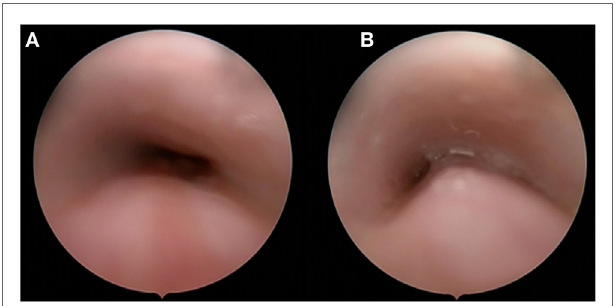
FiGURe 4 | Rigid endoscopy with telescope only at inspiration (A) and expiration (b)